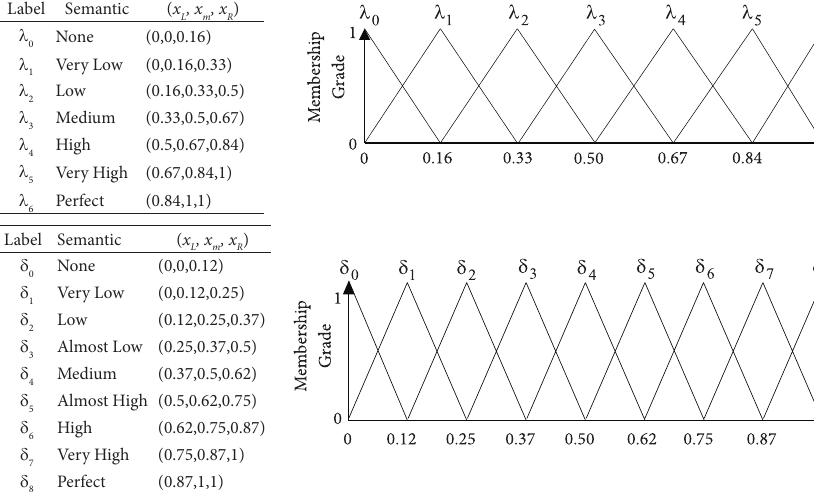
Fig. 3. The definition of linguistic variable l and